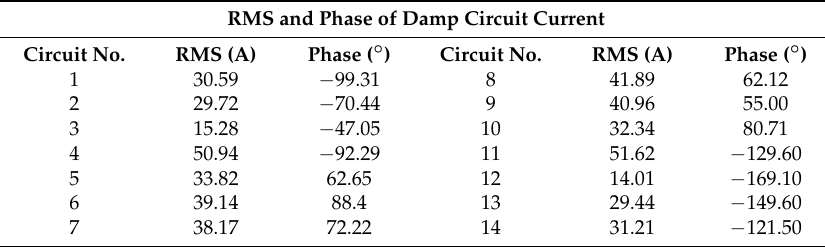
Table 3. Rotor damping loop steady-state current RMS and phase of fault experiment.